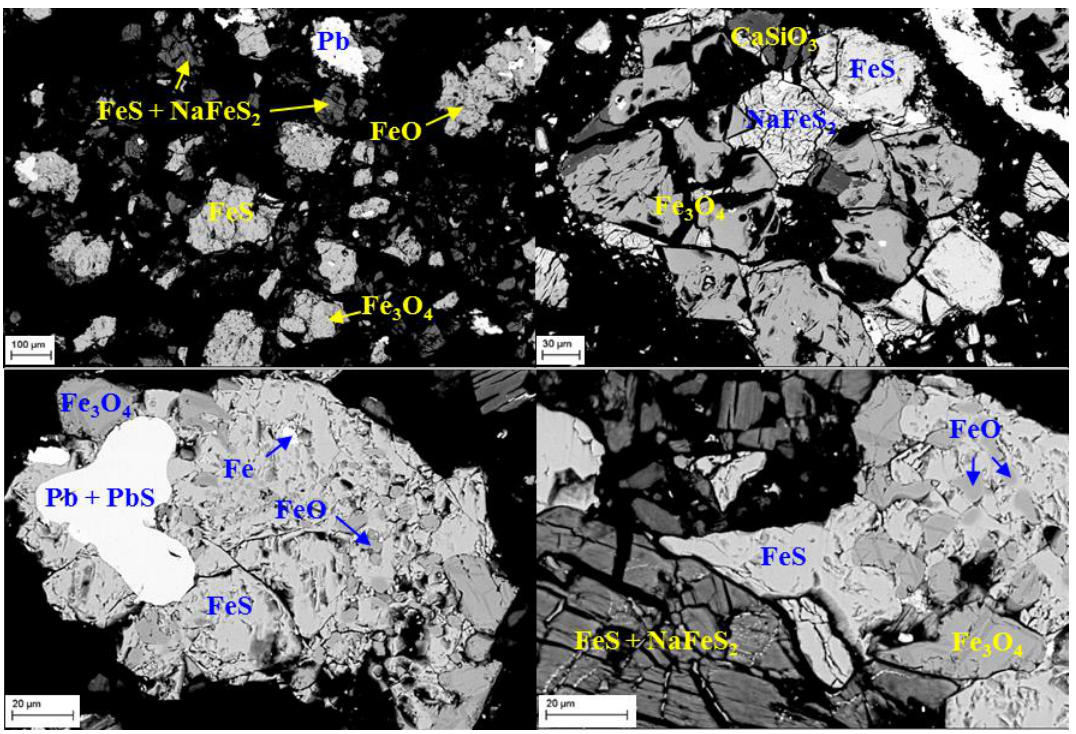
Figure 10. SEM-EDS results of the matte produced from conditions of W lead paste :W Na2CO3 :W pyrite Figure 10. cinder :W coke = 1500:60:375:180 g, FeO/SiO 2 = 1.3, CaO/SiO 2 = 0.4, 1200 °C, and 1.5 h.